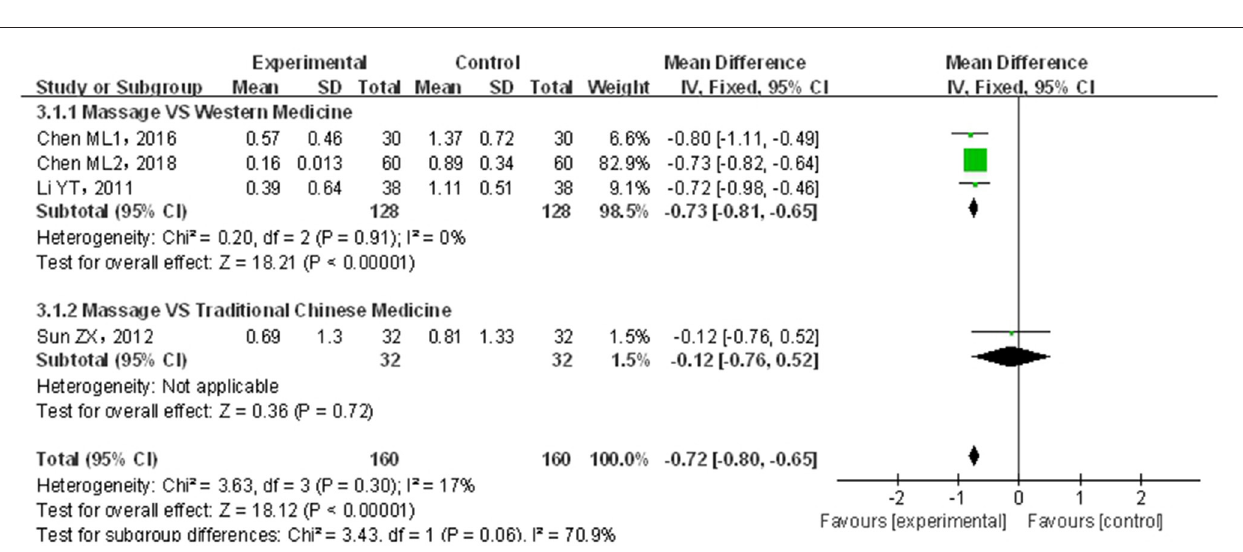
FIGURE 7 | Meta-analysis of infant massage and drug therapy in the treatment of children with functional constipation to reduce defecation difficulty score.